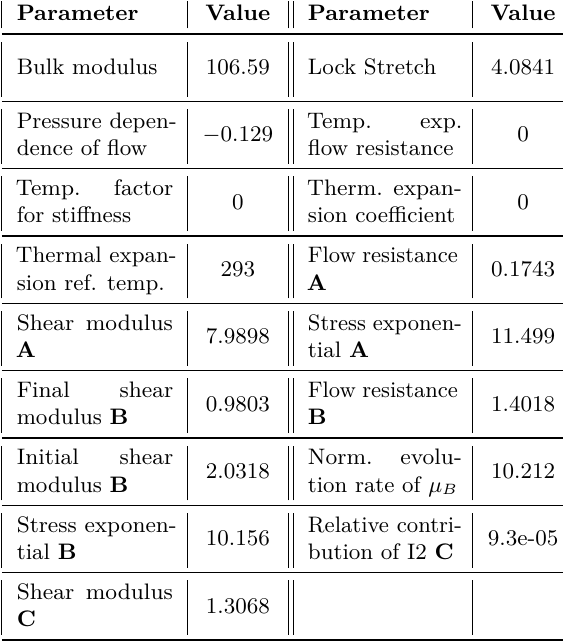
Table 1. Parameter table for three network material model.